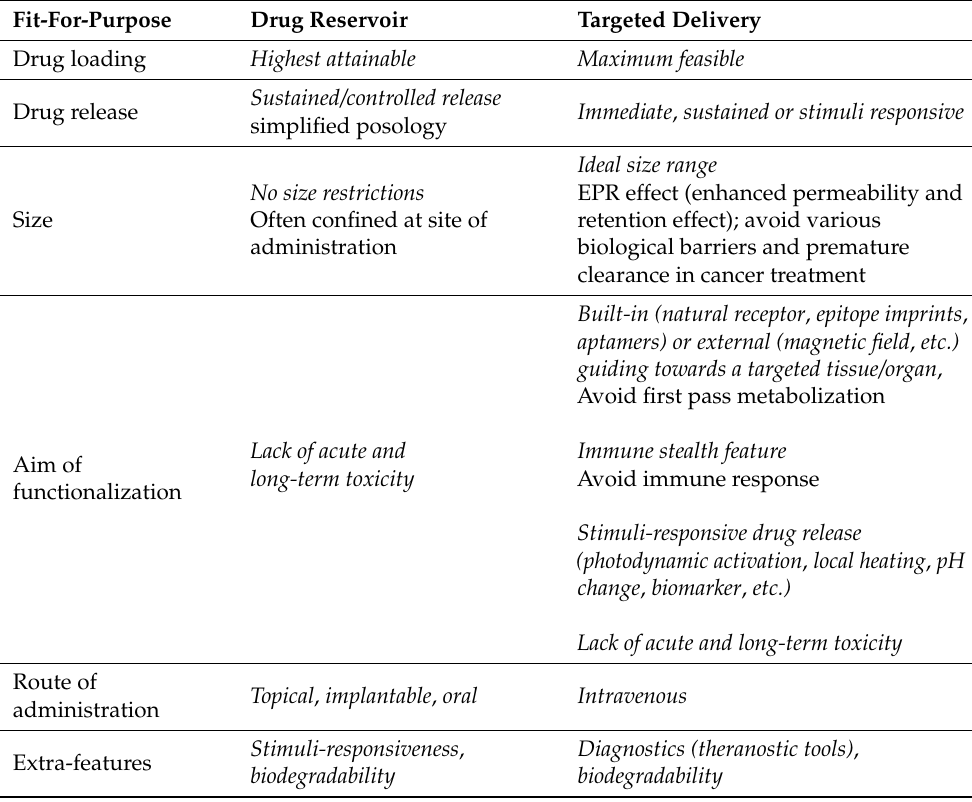
Table 1. Comparison of the characteristics of drug delivery systems based on fit-for-purpose